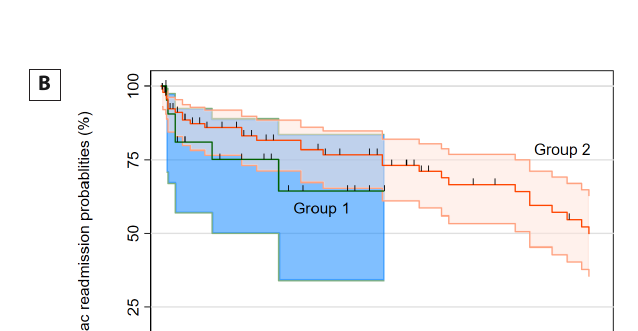
Supplementary Fig. 1 - Changes in ejection fraction in both groups.